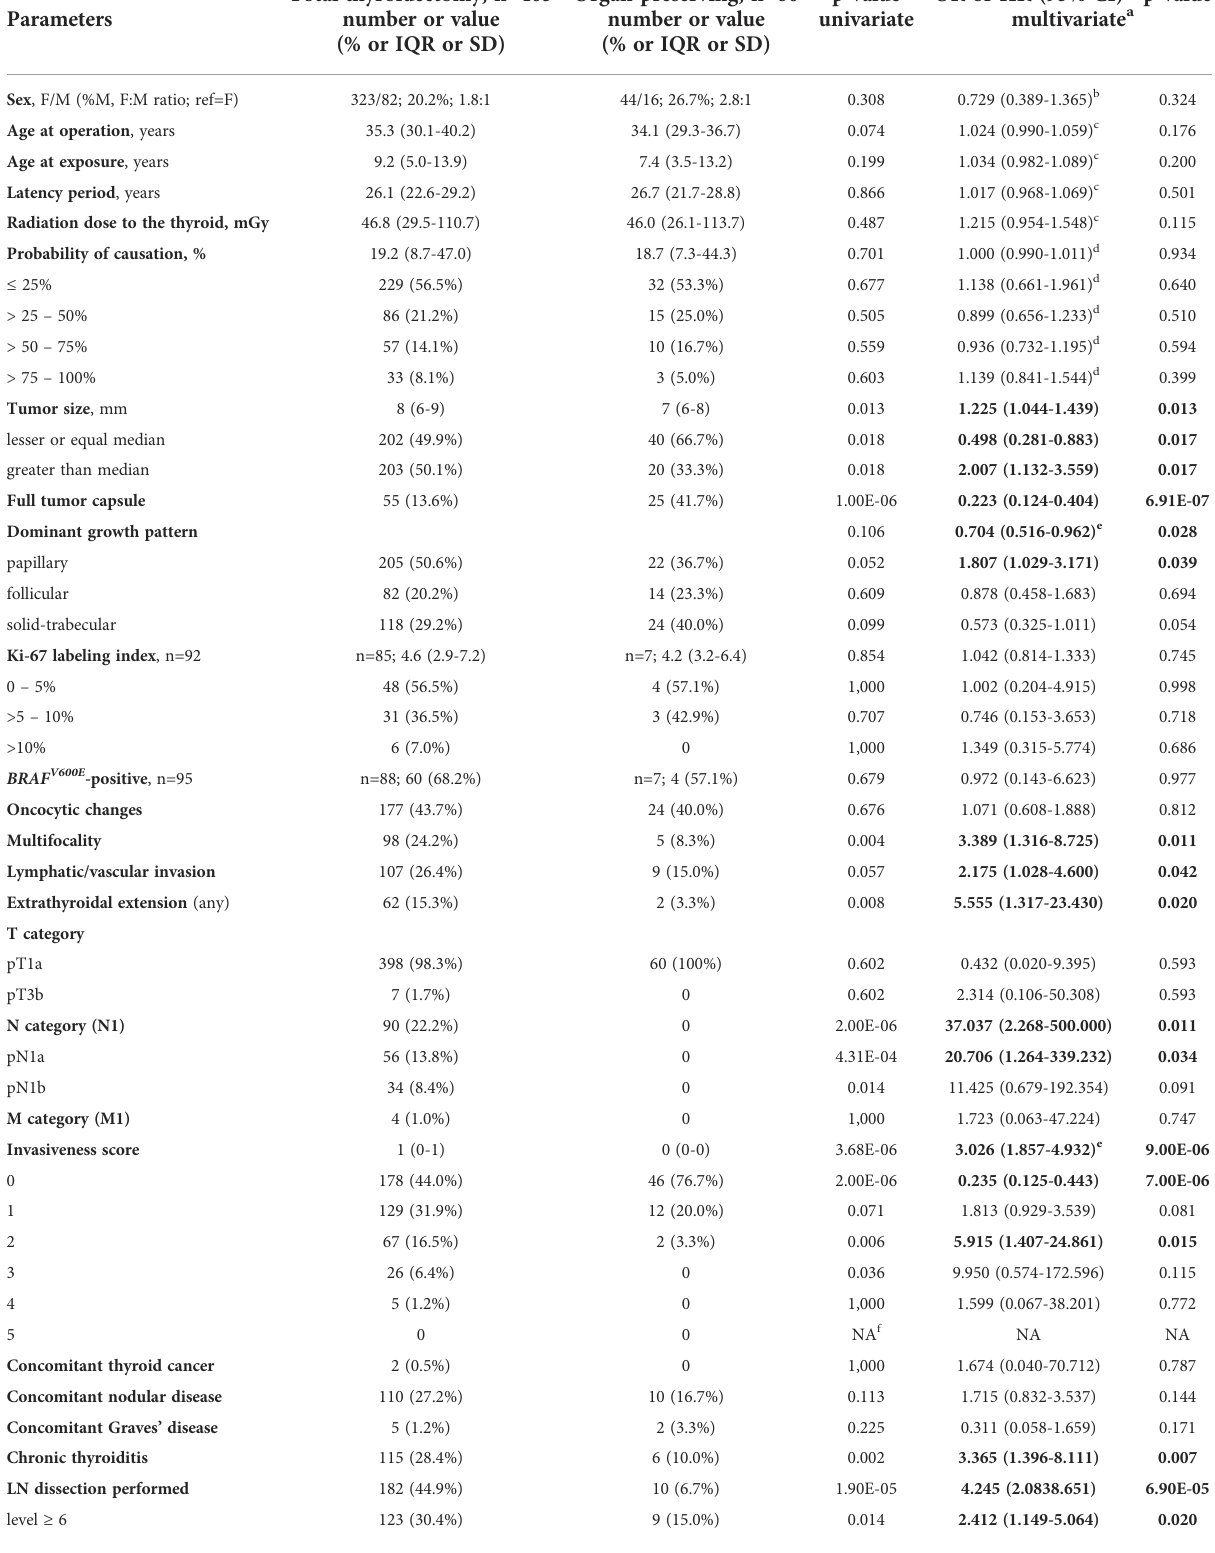
TABLE 6 Characteristics of the radiogenic papillary thyroid microcarcinomas by thyroid surgery